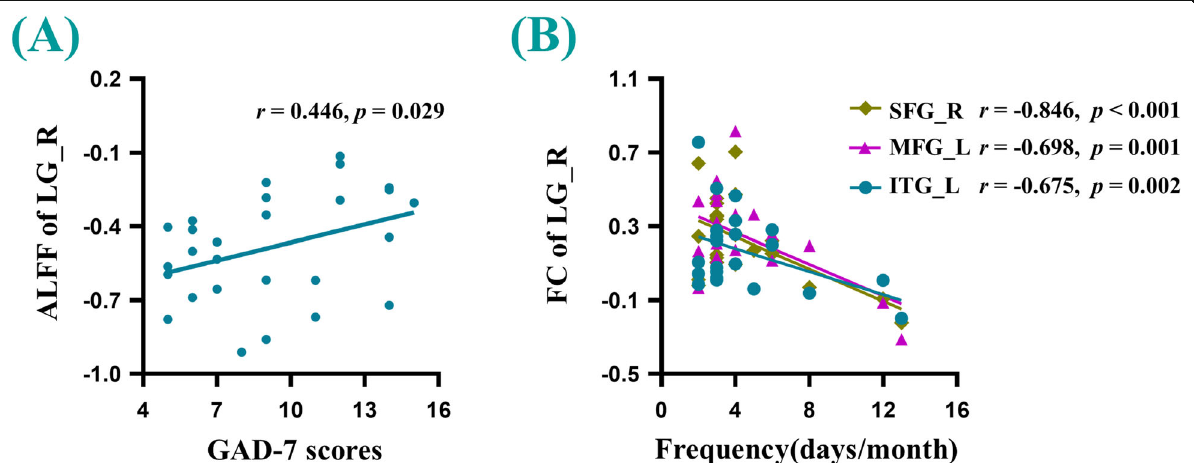
Fig. 3 a There was a significant positive correlation between the ALFF values of the right LG and the GAD scores in MwoA-A patients. b There were significant negative correlations between the functional connectivity of the right LG with right SFG, left MFG, left ITG and frequency of migraines in MwoA-OA patients. GAD-7: Generalized Anxiety Disorder seven-item scale. All abbreviations are defined in the Abbreviations